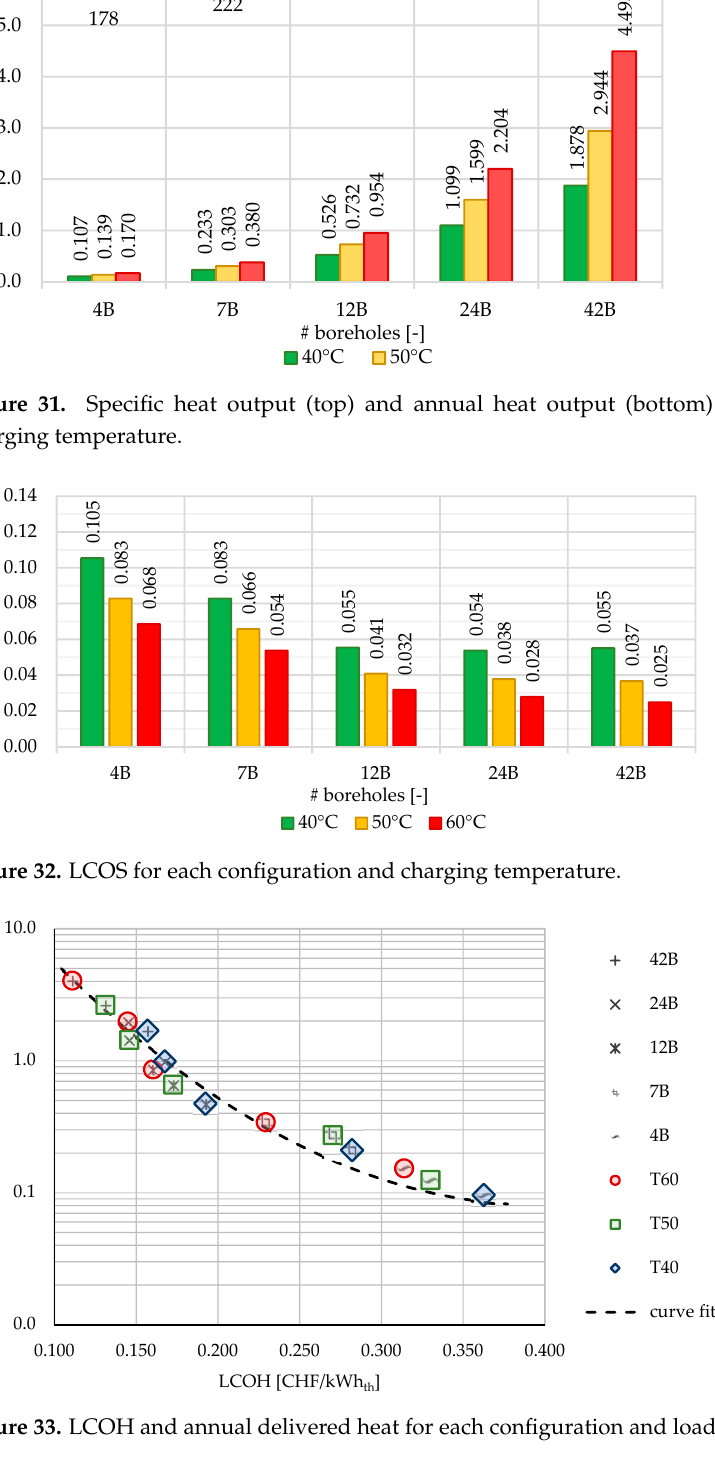
Figure 33. LCOH and annual delivered heat for each configuration and loading temperature.